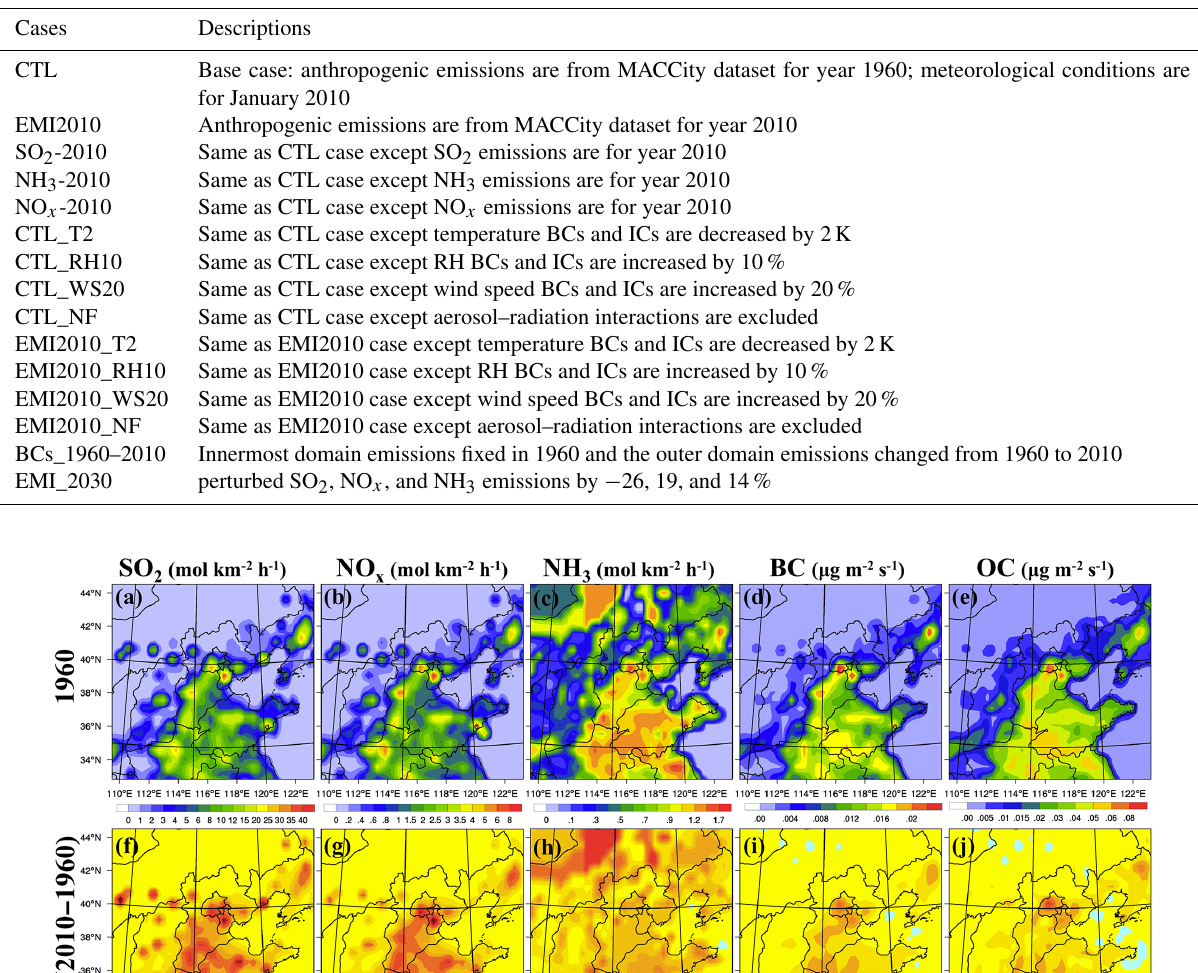
Table 1. Simulation cases and descriptions.